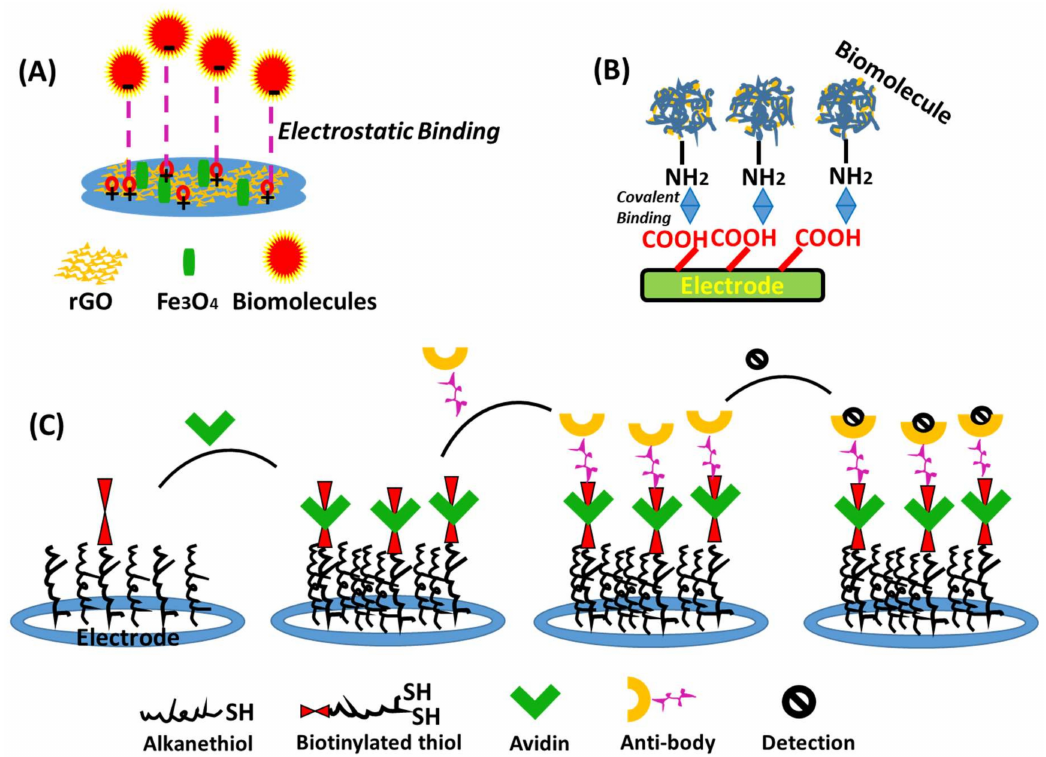
Figure 1. Overview of nanomaterial-based transducer surfaces in electrochemical biosensors; ( A ) Electrostatic binding; ( B ) covalent binding and ( C ) affinity